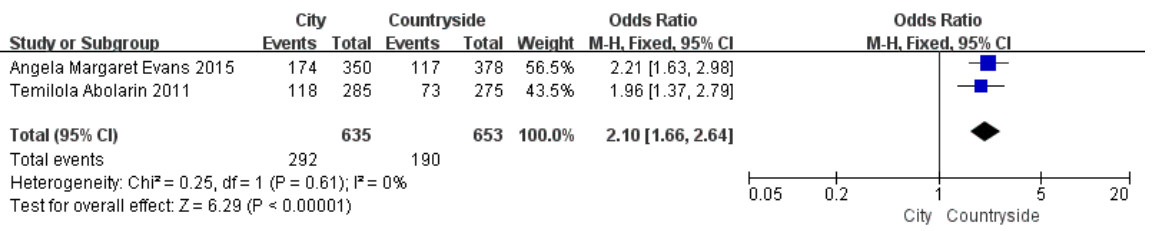
Figure 7. The forest plot of the region for flatfoot in children [11,17].